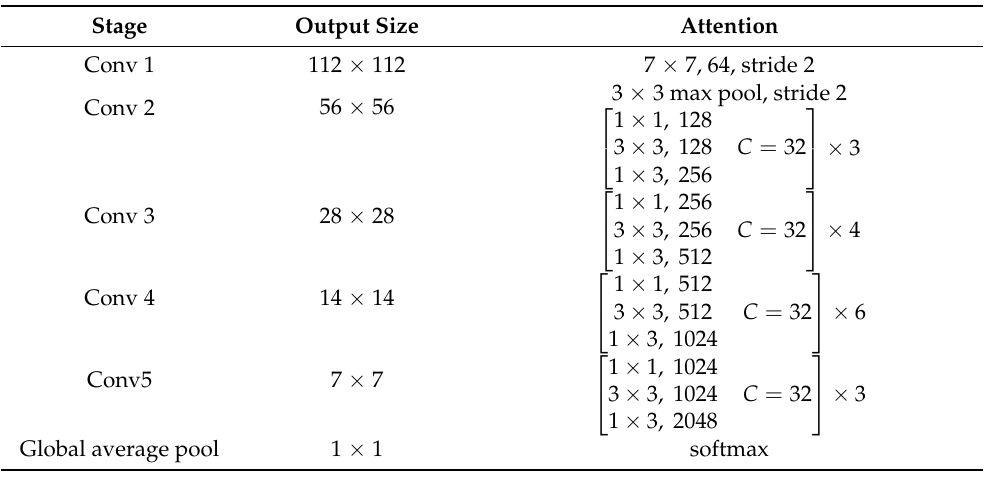
Table 1. Configuration parameters of HSC-Net.